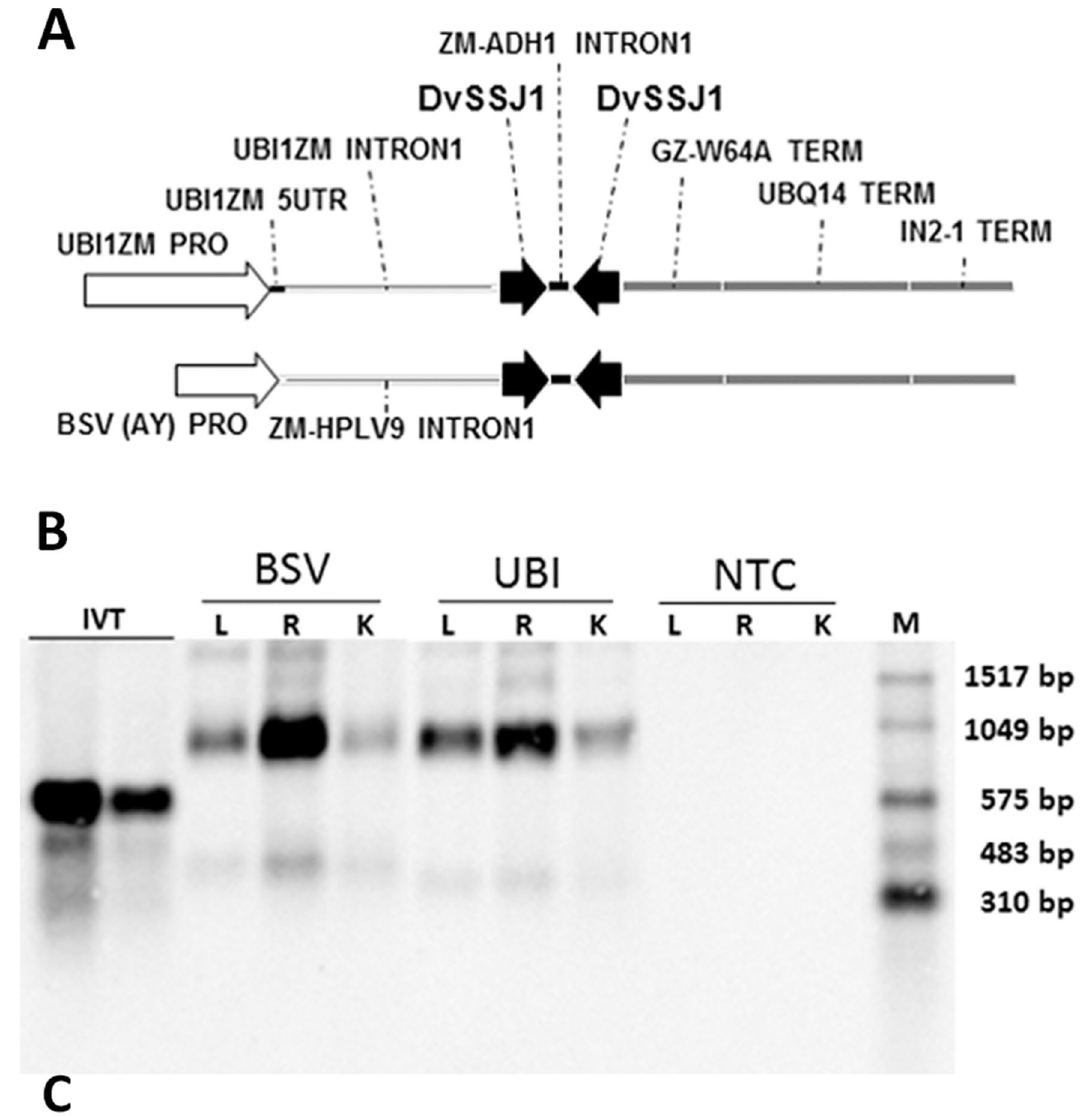
Figure 1. Charactering expression of DvSSJ1 transcript in T1 transgenic plants. ( A) Diagram of DvSSJ1 expression cassette containing a promoter and terminators; Intron region from the Zea mays ortholog of an Oryza sativa (rice) hypothetical protein (ZM-HPLV9); ( B ) Northern analysis of DvSSJ1 expression in transgenic tissues collected from leaf (L), root (R), and kernel (K); purified mRNAs (200 ng) were compared to in vitro transcription (IVT; 10 pg and 5 pg) of DvSSJ1 control and RNA size marker (M). Plants of non- transgenic control (NTC) were included. The blot was probed with the 210 bp DvSSJ1 antisense riboprobe labeled with digoxigenin. The estimated amount (pg) of the top band were analyzed by ImageJ. ( C ) The sequence of the full DvSSJ1 transcript was analyzed by both cDNA sequencing and 5 ′ and 3 ′ RACE (Supplementary Fig. 2). The 901-nucleotide (nt) of full DvSSJ1 transcript (UBI promoter; 900 nt for BSV) contains the 5 ′ or 3 ′ end of additional sequences shown in black and capital letter, which are partially matched to 5UTR of maize polyubiquitin ( C ; S94464.1) and terminator of maize zein Zc2 gene ( D ; X53514.1) as part of the construct elements. Underline part of the sequence (232 bp) can form dsRNA stem and loop region in the middle (590 nt). DvSSJ1 210 bp was highlighted in red and truncated maize ADH1 intron1 in